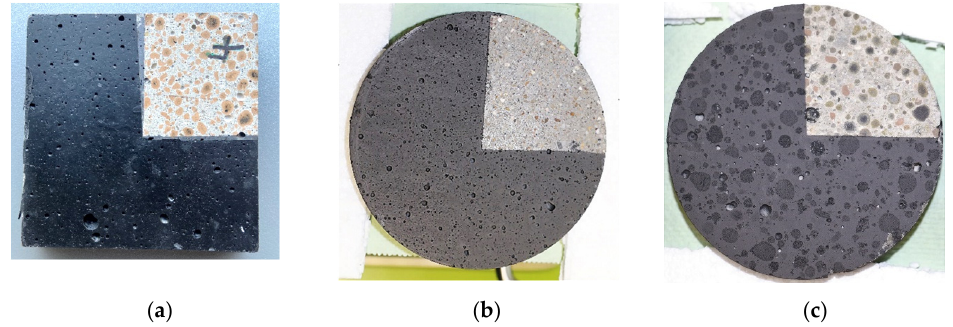
Figure 4. ( a ) Partially coated concrete sample type 1 (side length: 10 cm); ( b ) partially coated concrete sample type 2 (diameter: 10 cm); ( c ) partially coated concrete sample type 3 (diameter: 10 cm). The main material parameters of the different concretes are compiled in Table 2. Table 2. Density and thermal conductivity of the investigated concrete